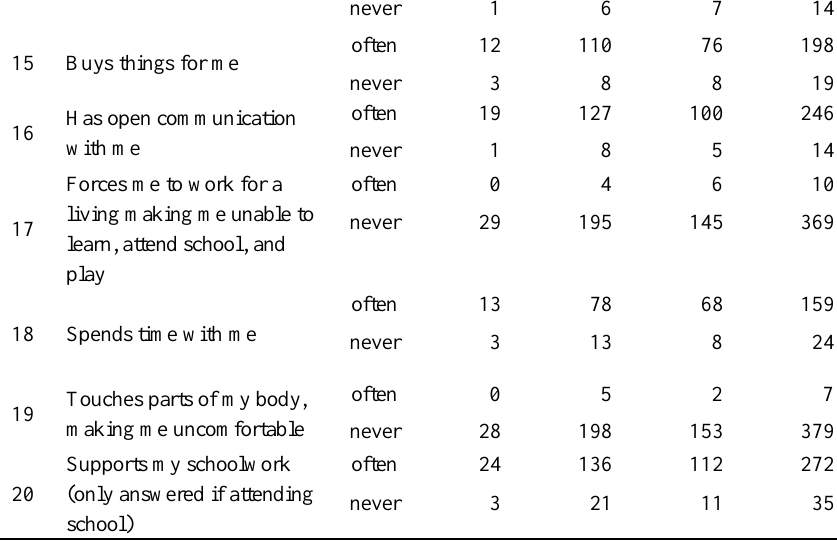
Table 3 indicates that age correlates with adolescents’ risky behaviors. Risky behaviors were performed mostly by older adolescents from 13 to 18 years. Alarmingly, some children aged 13 to 15 already smoked (6%), drank alcohol (1.4%), and engaged in brawls (2.8%), in physical fights (5.5%), and in heavy petting (0.5%). Table 3 also shows that smoking (5.6%), physical fights (4.6%), and brawling (2.2%) were the riskiest behaviors in which adolescents were involved. Although in relatively small numbers, some adolescents also engaged in consuming alcohol (1%), substance use (0.2%), heavy petting (0.5%), and premarital sex